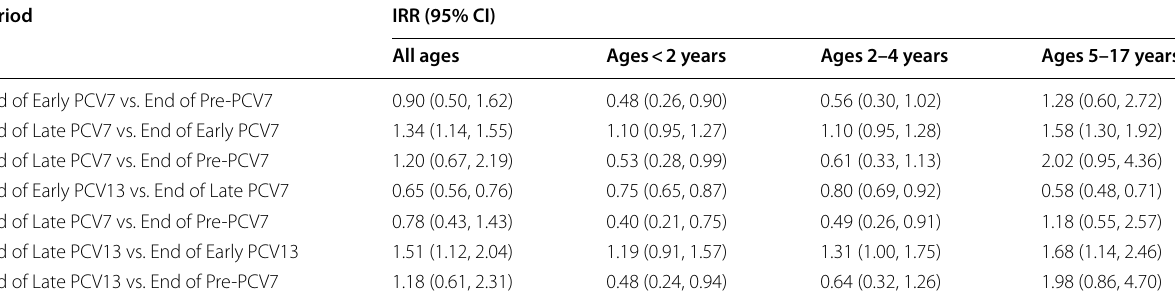
Table 4 Estimated changes in ACP IRs at the end of each PCV study period vs. prior period and pre‑PCV7 period among